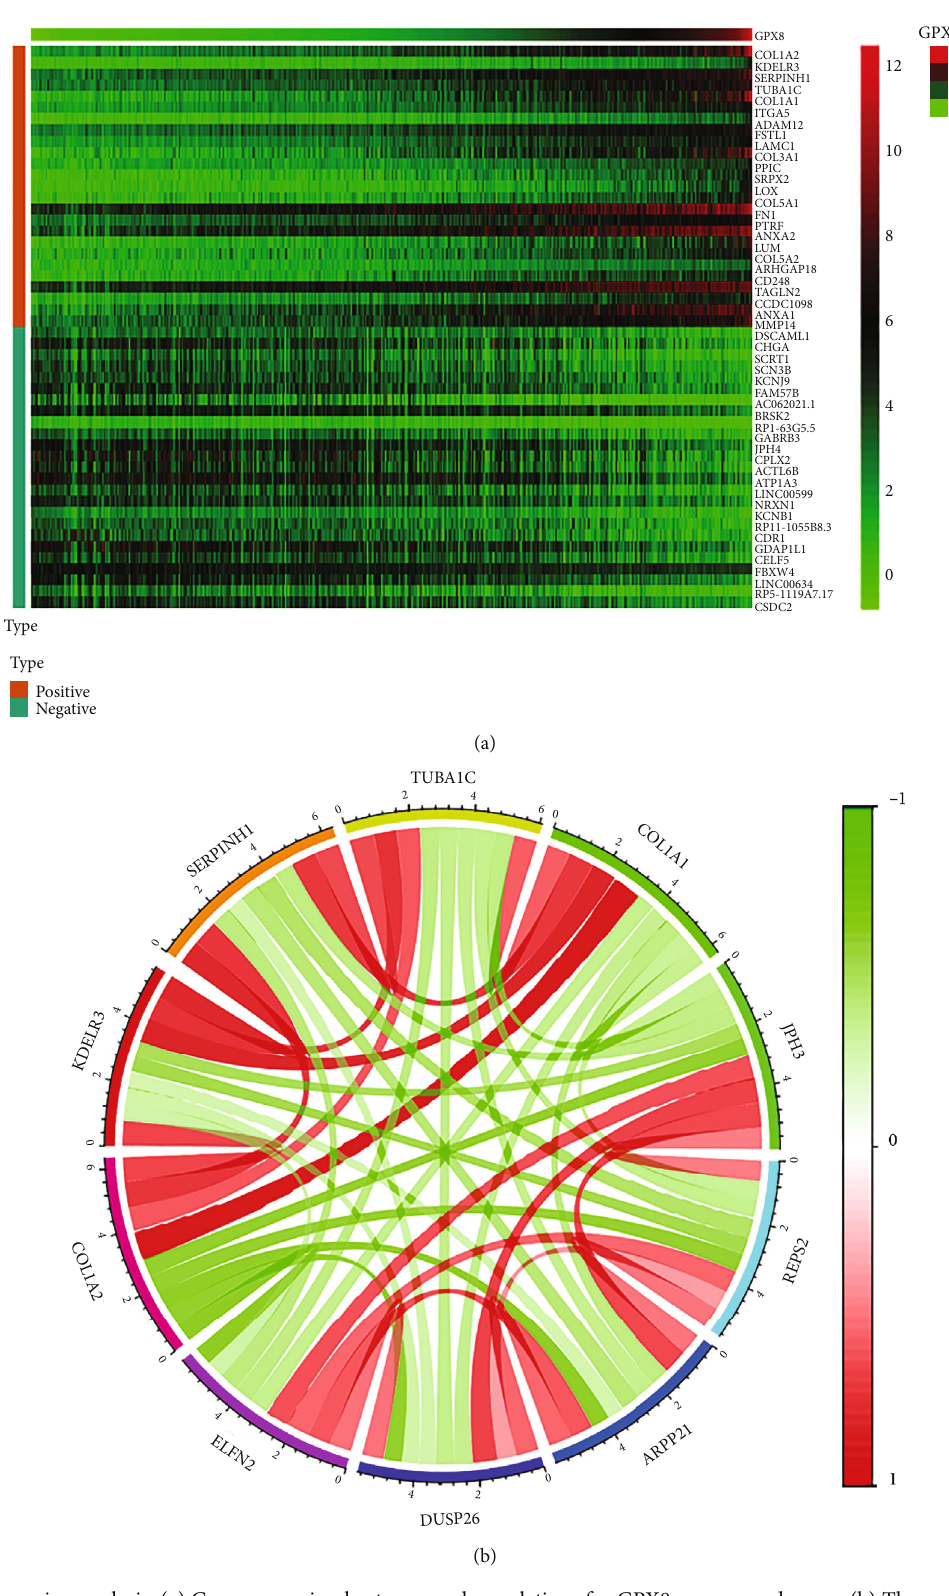
Figure 5: Coexpression analysis. (a) Gene expression heat map and correlations for GPX8 coexpressed genes. (b) The coexpressed network of 5 positively related and 5 negatively related genes for